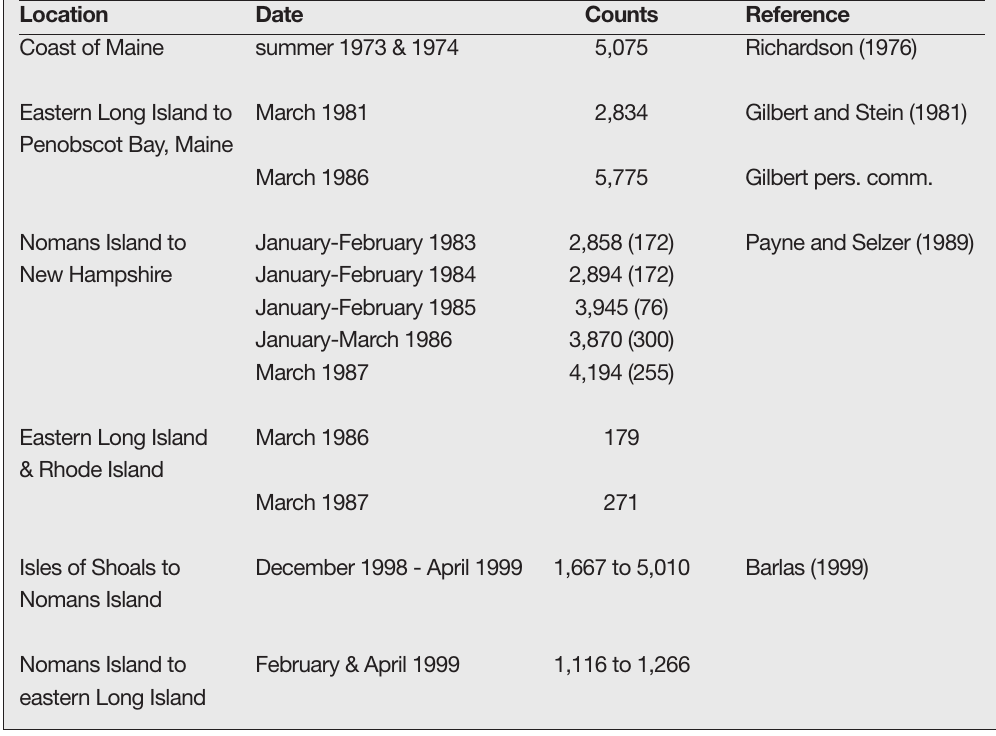
Table 1. Summary of 1973 to 1999 uncorrected seasonal counts (see Table 2 for abundance survey counts) of harbour seals in U.S. Atlantic waters, 95% confidence interval are in parentheses.